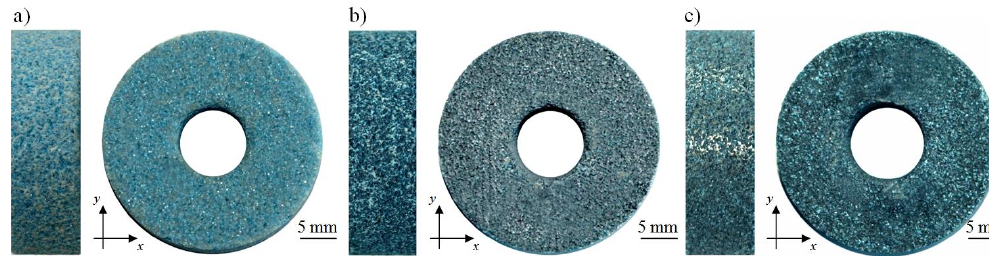
Figure 2. General view of 1-35×10×10×109A5X60L10VE01PI-50 grinding wheels used in the Figure 2. experimental studies: ( a ) M—non-impregnated reference wheel; ( b ) 1M40—MoS 2 -treated wheel; ( c ) 2M20—MoS 2 -treated wheel after the internal cylindrical grinding of INCONEL ® alloy 718.